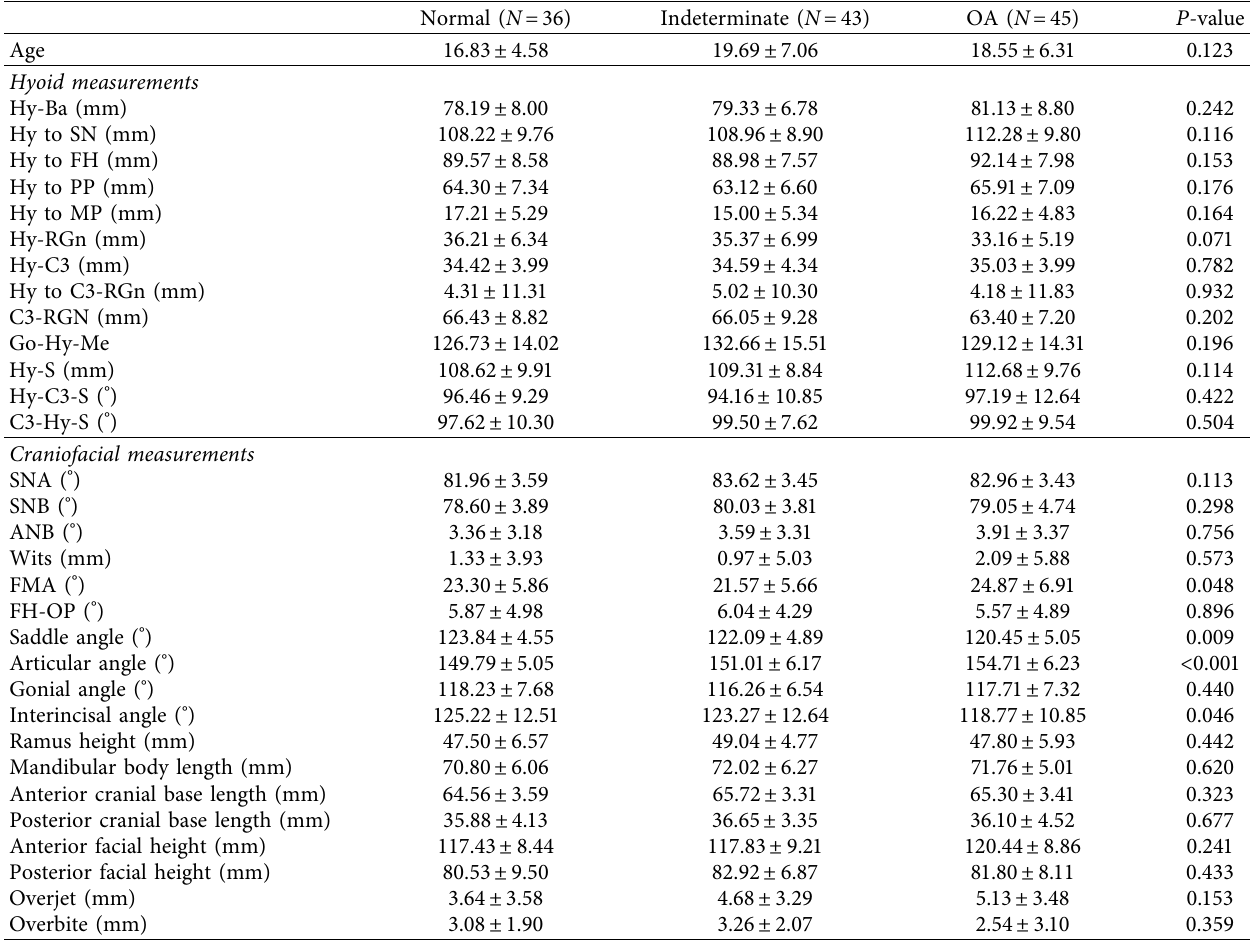
Table 6: Differences in hyoid and craniofacial measurements among the three groups in male subjects.